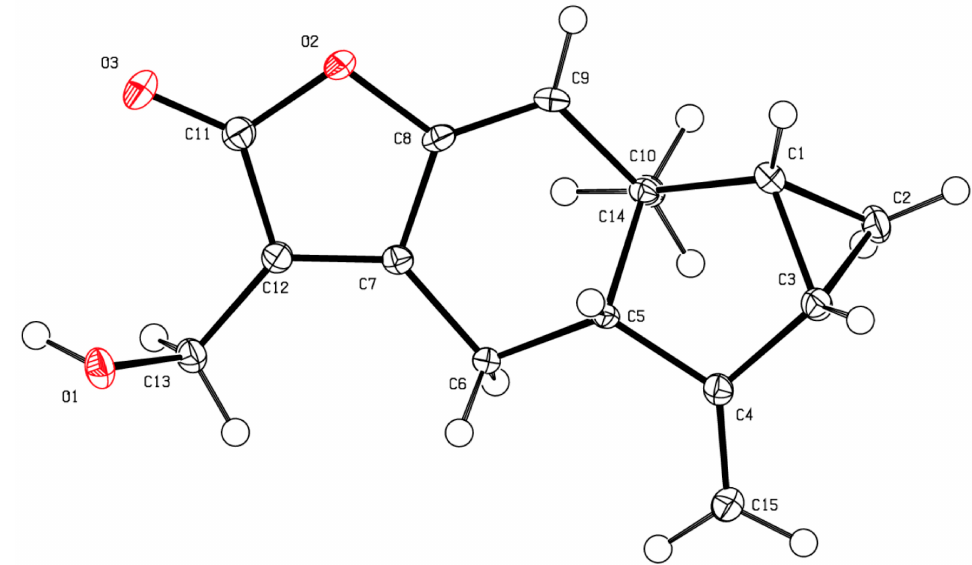
Figure 5. A 3D-ORTEP projection of the X-ray crystal structure of Compound 4 with 50% probability ellipsoids.